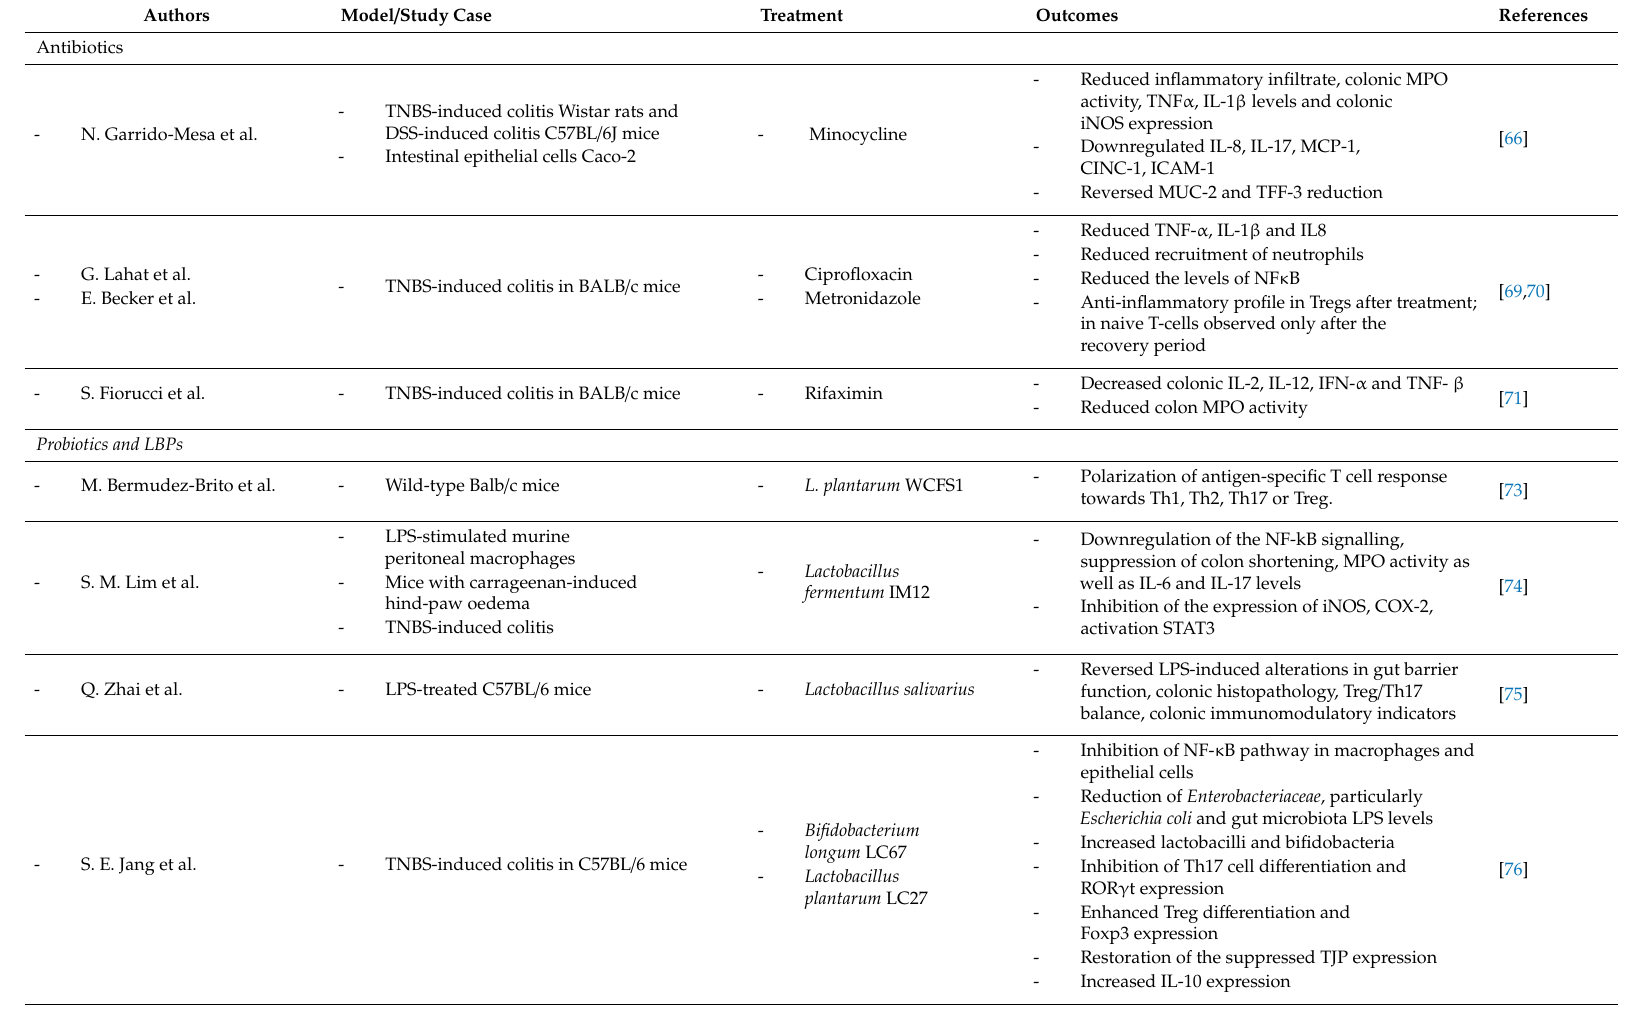
Table 1. Microbe-targeted therapies for